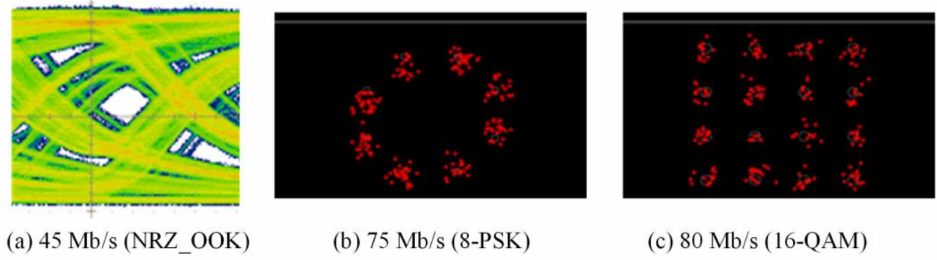
Figure 12. Pure data transmission rate of Blue LED with bandpass filter (BER = 10 − 3